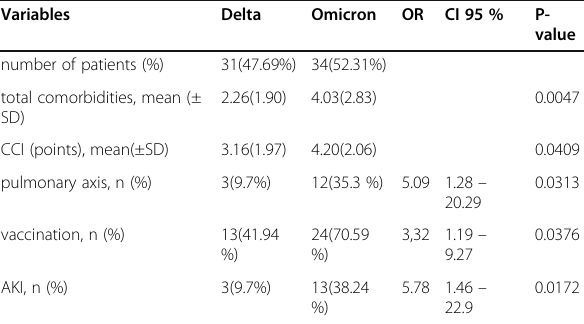
Table 1 (abstract A107). Significant variables in the univariate analysis compared data belonging to Delta and Omicron on ICU COVID admission. Values are means (±S.D.) or number (%). OR: odds ratio; CI: confidence interval.